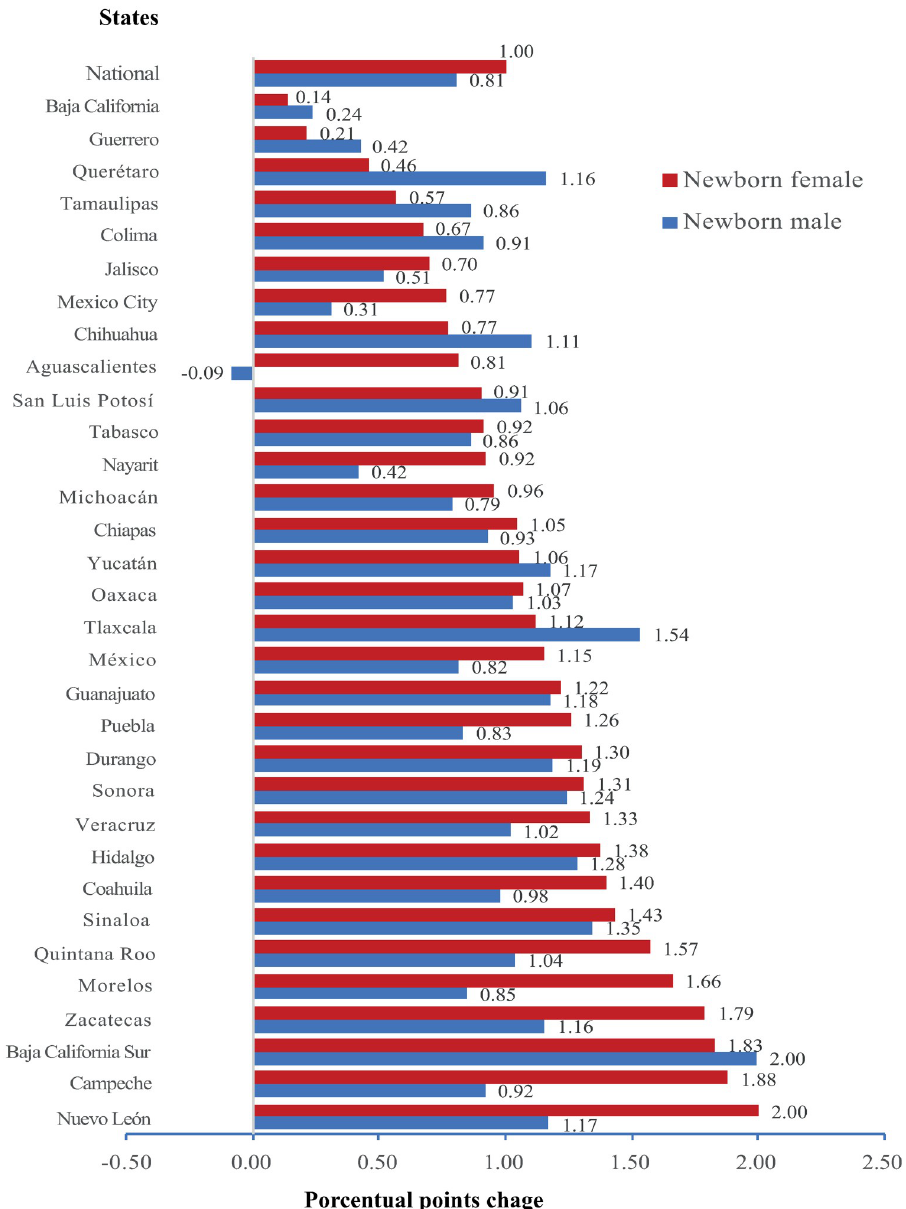
Fig 3. Change in LBW incidence between 2008 and 2017, at national and state levels. state with the highest increase in the incidence of LBW in males was Baja California Sur (2.00 pp, p < 0.0001); whereas in females was Nuevo Leo´n (2.00 pp, p < 0.0001) (Fig 3). The change in LBW incidence from 2008 to 2017 was 13% in males and 17% in females (p < 0.0001 for both cases) (Table 1). This change varies by state and only Baja California did not show a significant increase in the RR. At the national level, the State of Mexico, Morelos, Nuevo Leon, Veracruz and Zacatecas, the RR in females was higher than in males (Interaction sex � year, p < 0.1).